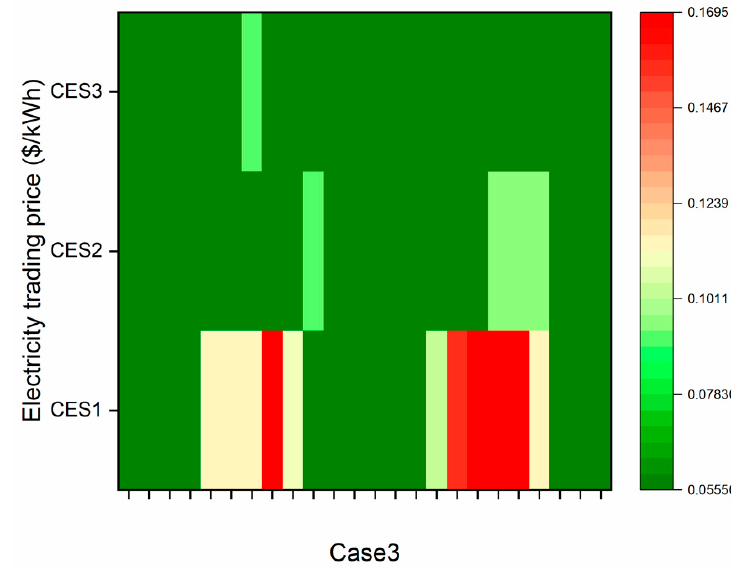
Figure 3. Electricity trading prices for each